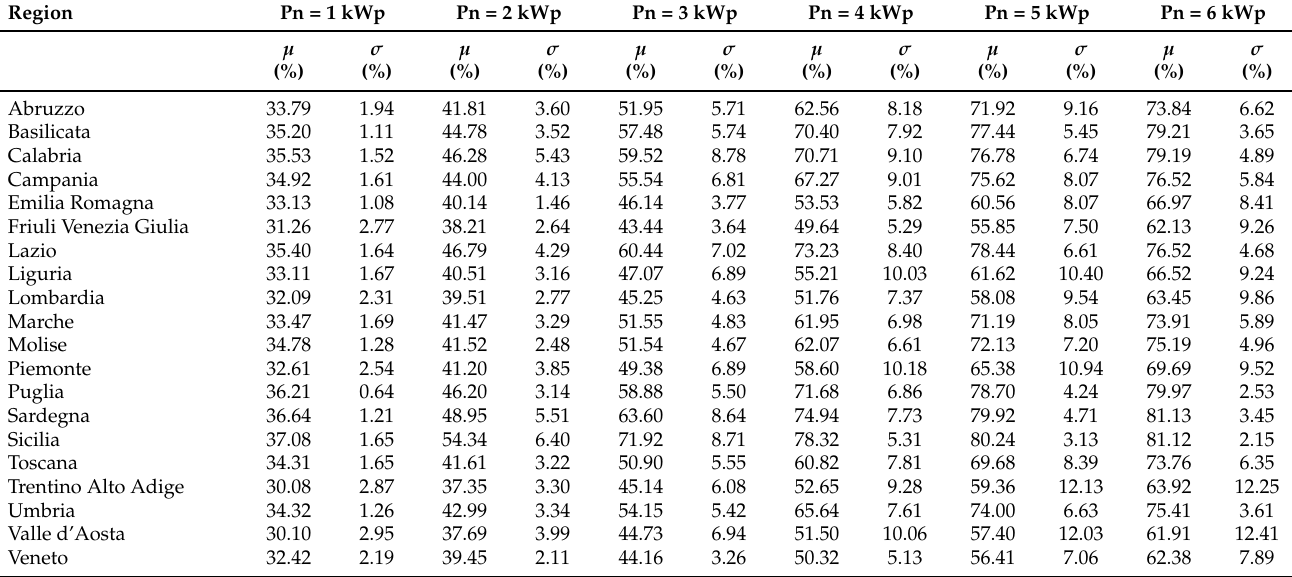
Table 13. Self-Sufficiency for E L = 2700 kWh with